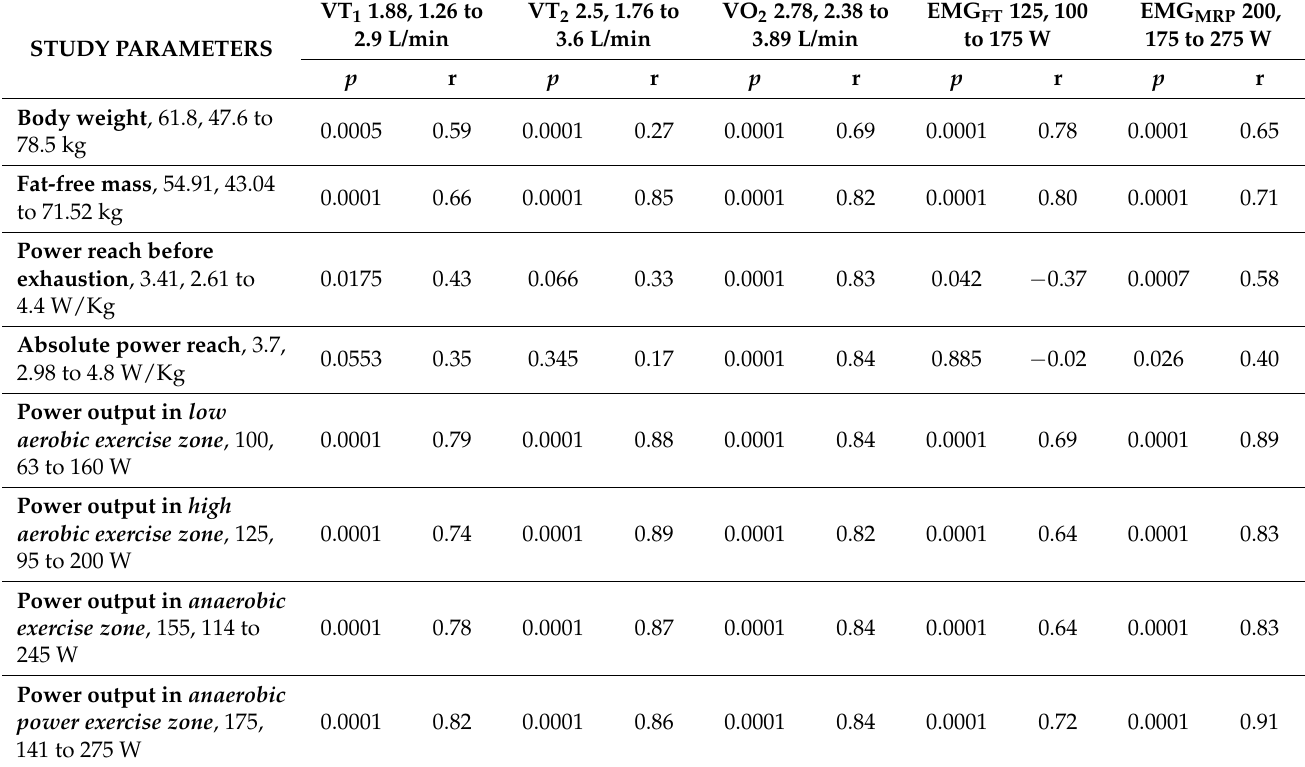
Table 2. Comparative data over the cardiopulmonary test results and EMG measures.